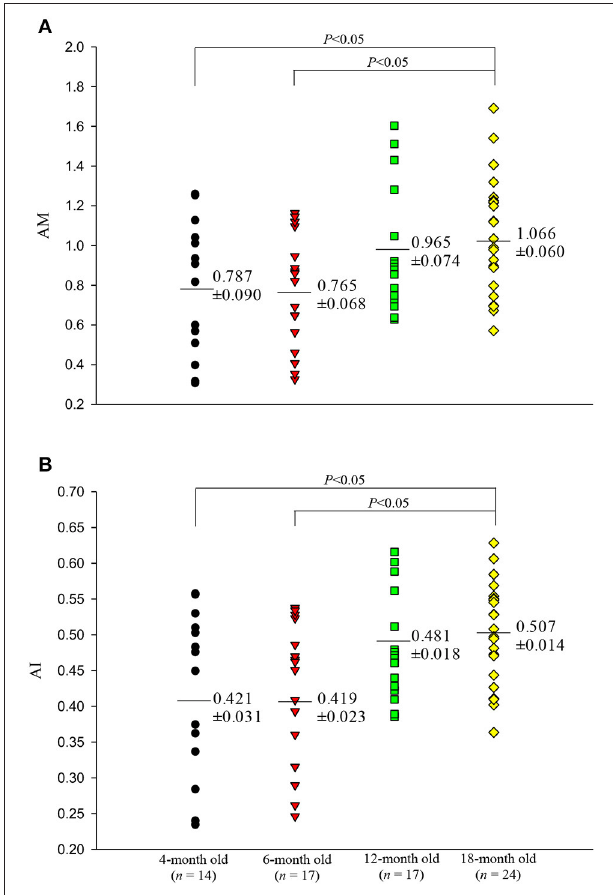
FIGURE 5 | Effects of aging on augmentation magnitude AM (A) and augmentation index AI (B) . The rats aged 18 months had significantly higher AM and AI than did those aged 4 and 6